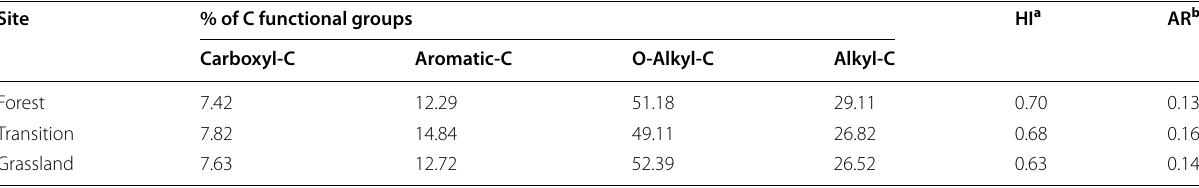
Table 4 CP/MAS 13 C NMR of distribution of organic carbon functional group of whole soils in different sampling